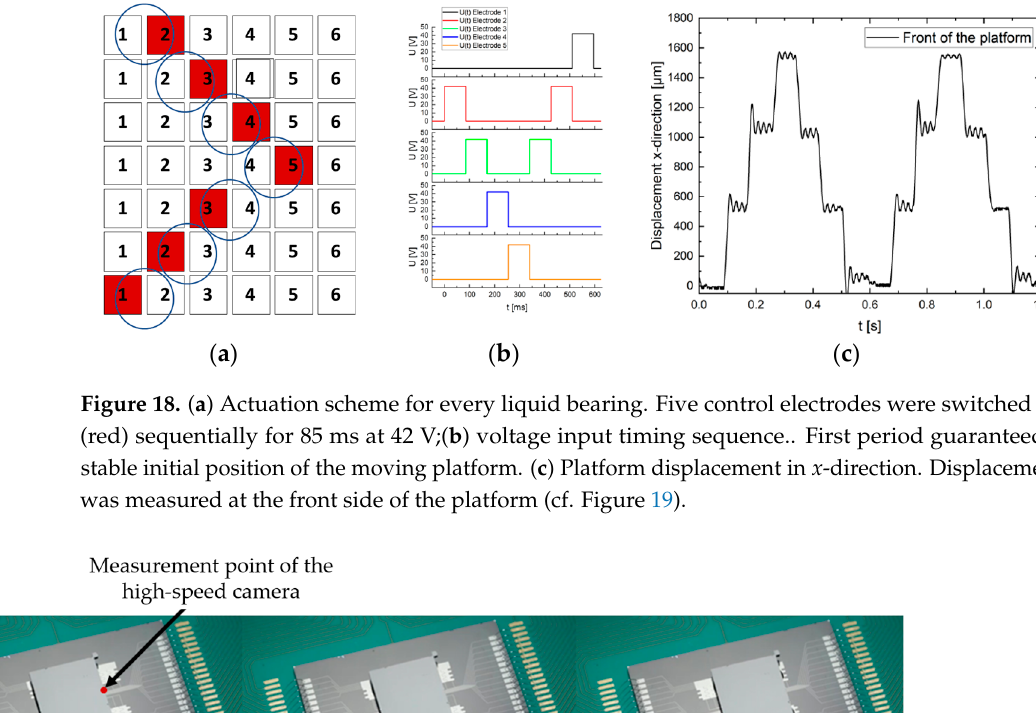
17 of 22 Figure 17. ( a ) four droplets in their initial positions on the two electrode arrays; ( b ) four droplets on the electrode arrays serving as liquid bearings, carrying a 220 µm thick silicon platform; ( c ) Transi- tion velocity of one single liquid bearing without a payload between two electrodes, as a function of the applied voltage. A stable movement with the payload of the platform could be achieved at 40 V. A video of the moving platform is available at h tt ps://etit.ruhr-uni-bochum.de/mst/for-